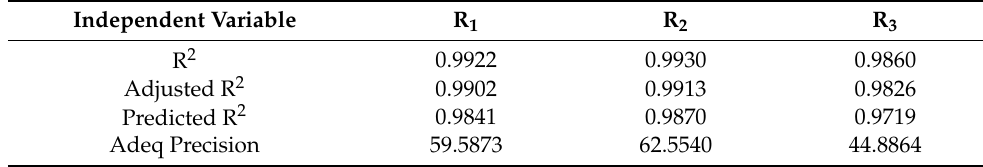
Figure 1. ( a ) 3D-response surface plot and ( b ) linear correlation plot between predicted versus actual values for illustrating the influence of variables A and B on particle size (R 1 ). Table 4. Fit statistics for the independent